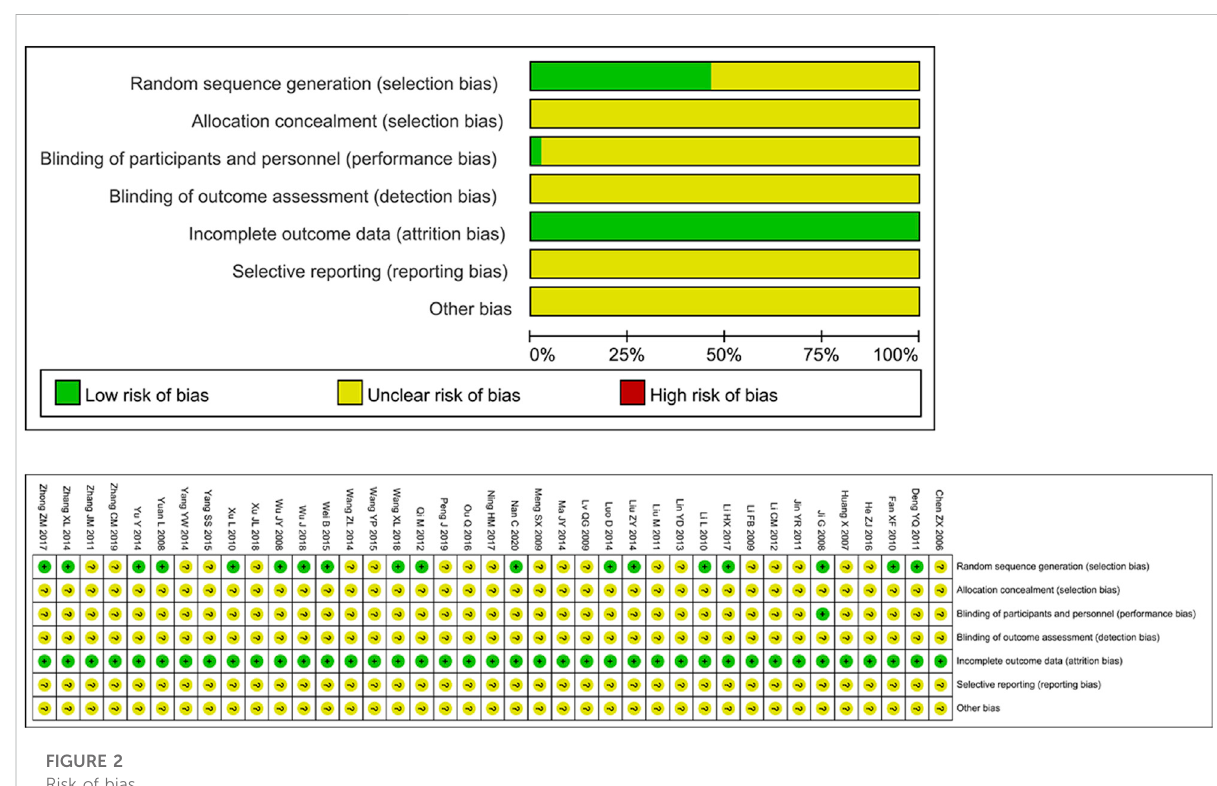
FIGURE 2 Risk of